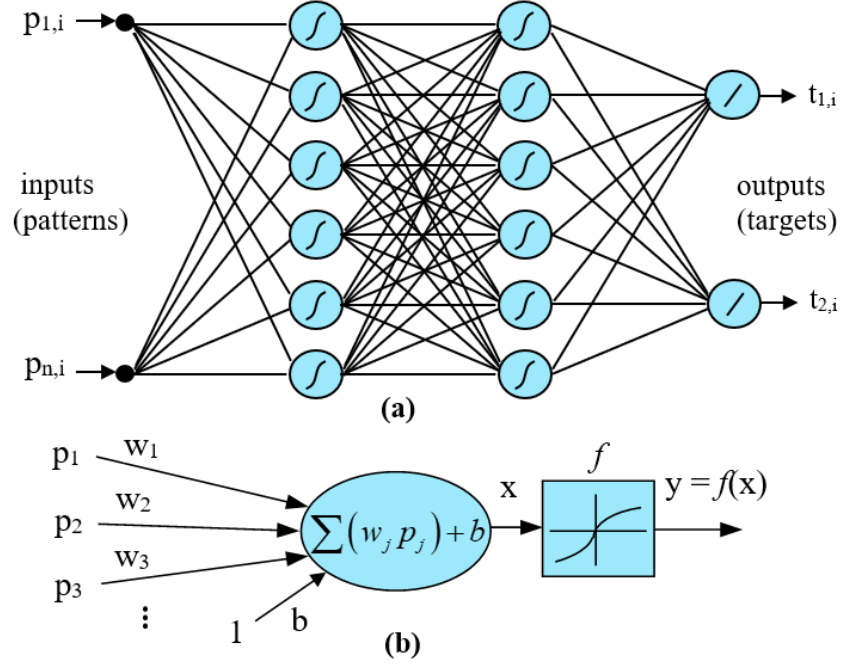
Figure 4. MLP topology: ( a ) network containing n input units, two 6-neuron hidden layers and 2 neurons in the output layer, where the subindex “ i ” stays for the different training patterns; ( b ) detail of the neuron function, where p j are the neuron input values, w j are the connection weights, and the subindex “ j ” stays for the different neuron inputs.